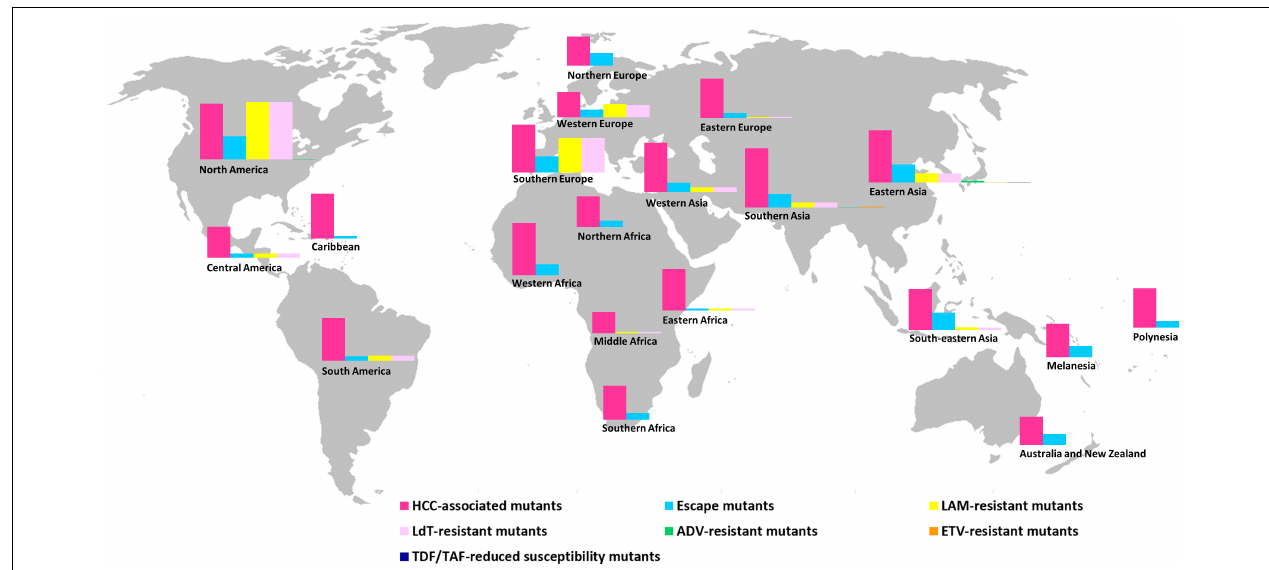
FIGURE 3 | Prevalence of HBV mutants in different geographic regions based on 6,207 complete genome sequences present in the HBVdb database. The map was reconstructed using Wikimedia Commons (https://commons.wikimedia.org/wiki/File:BlankMap-World-noborders.png), this figure is similar but not identical to the original image and is therefore for illustrative purposes